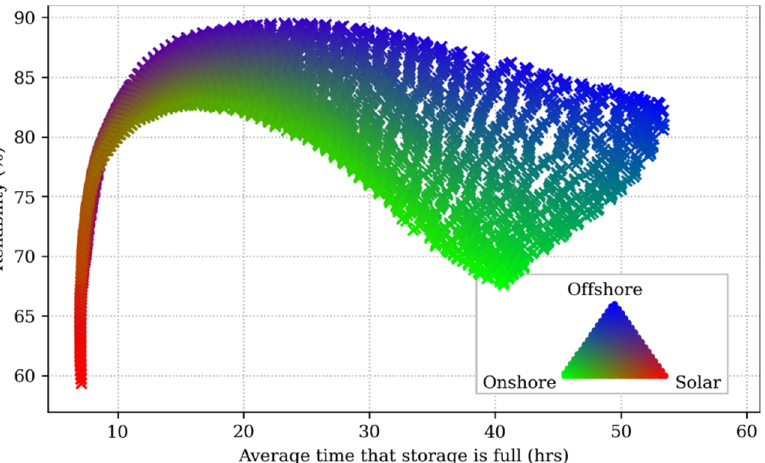
Figure 6. A scatter plot showing the reliability of different system designs against the average number of consecutive hours for which the energy storage was fully charged. Each system design has an annual generation of 350 TWh/y and 300 GWh of storage. The colour of the markers indicates relative contribution of each generation technology to the total annual energy generation.